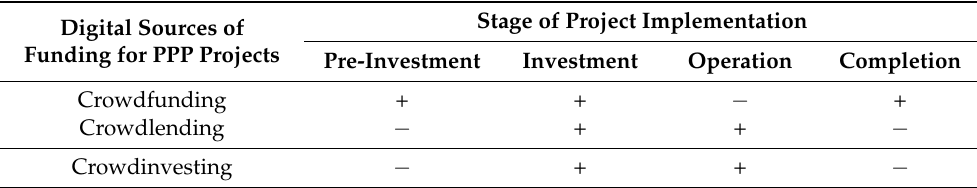
Table 8. Digital sources of funding for the PPP projects based on the implementation stage.